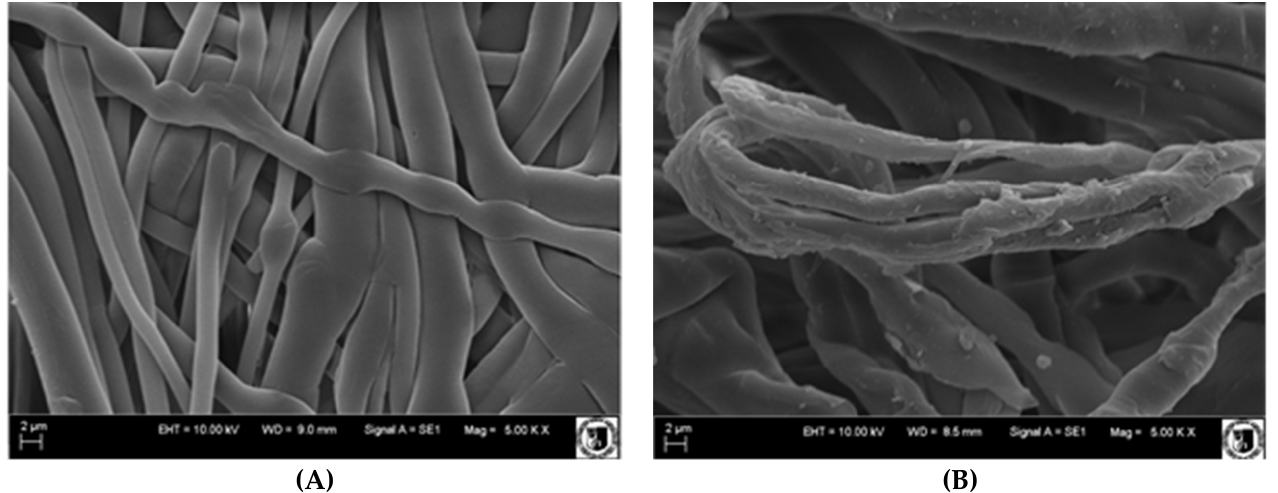
Figure 7. Scanning electron microscope (SEM) images of membranes: ( A ) before modification and ( B ) and with imprinted layer: G-series, the grafting yield (GY) 1.34 mg/cm 2 .